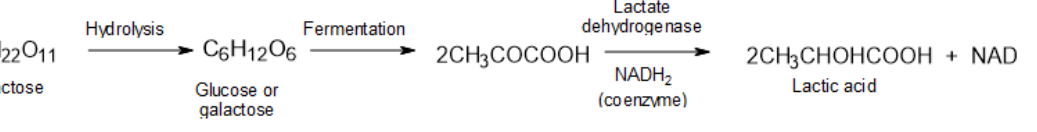
Figure 3. Scheme presenting receiving lactic acid [5].